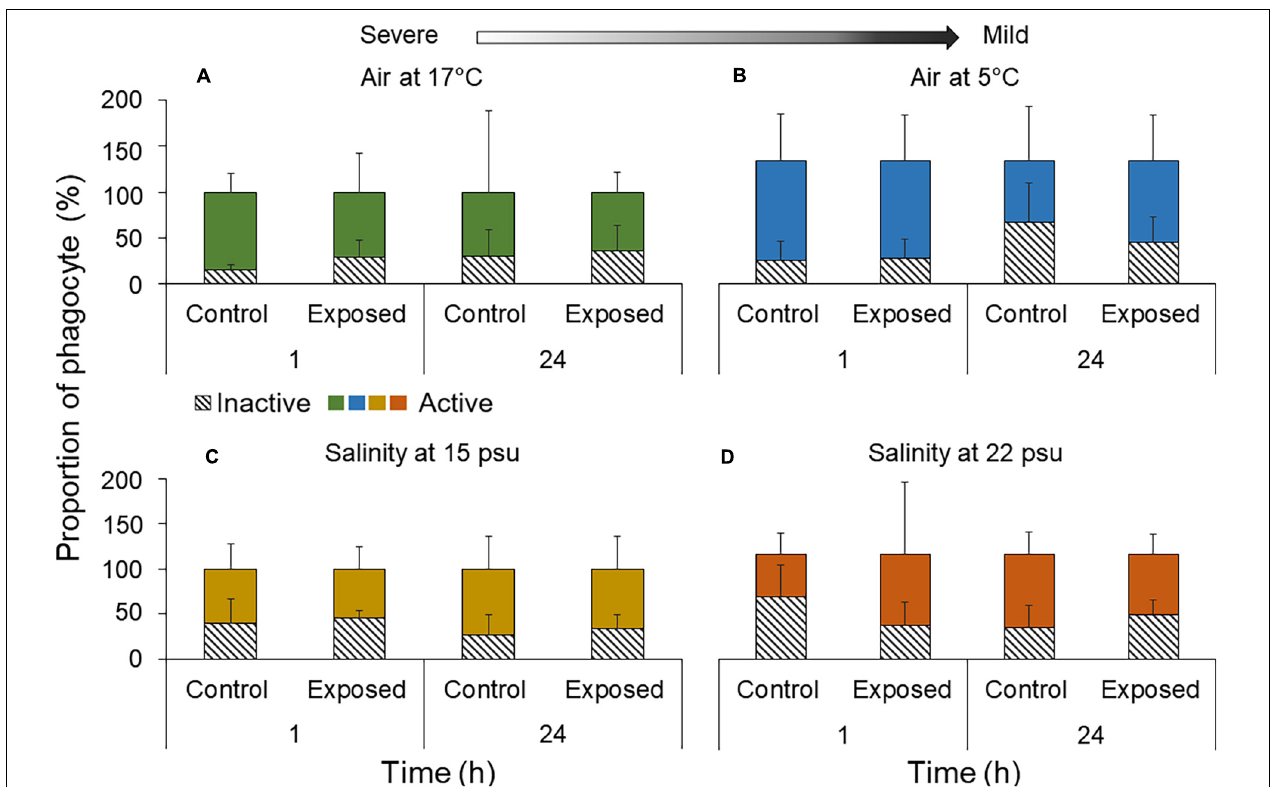
FIGURE 3 | Proportion of phagocytes (active vs. inactive) per mL of Polian vesicle fluid (mean ± SD, n = 5–10) following exposure to (A) 17 ◦ C air, (B) 5 ◦ C air, (C) 15 psu salinity, and (D) 22 psu salinity. Measurements were made immediately after the exposure (1 h) and after a 23 h recovery period (total duration of 24 h). Arrow indicates severe and mild stressors relative to the